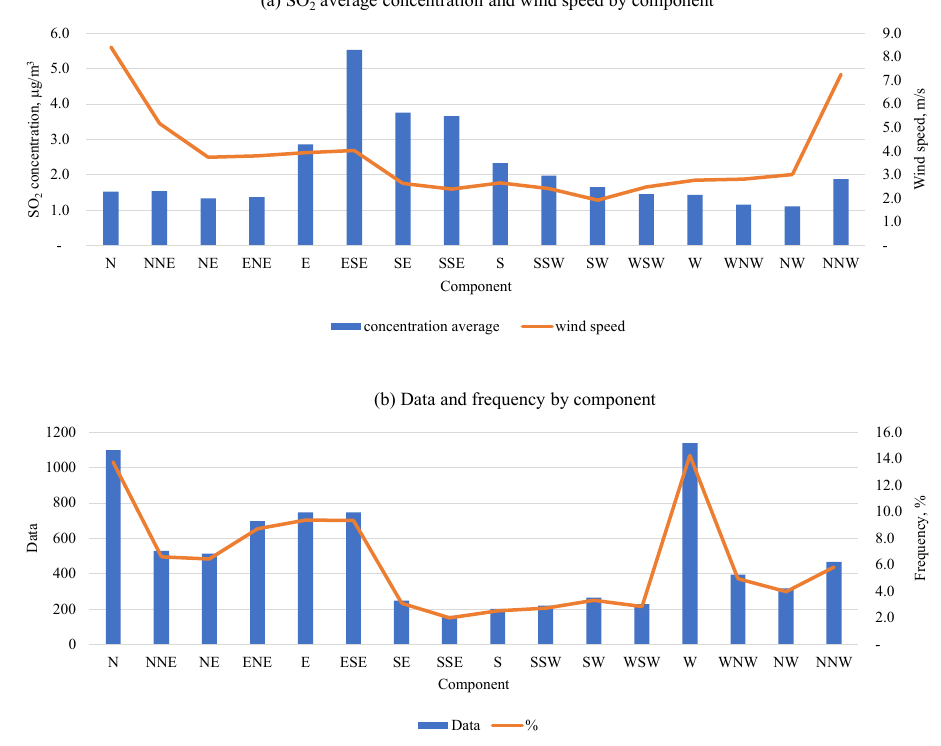
Figure 7. Air quality information for ( a ) SO 2 concentration and wind speed, and ( b ) data and frequency by component.